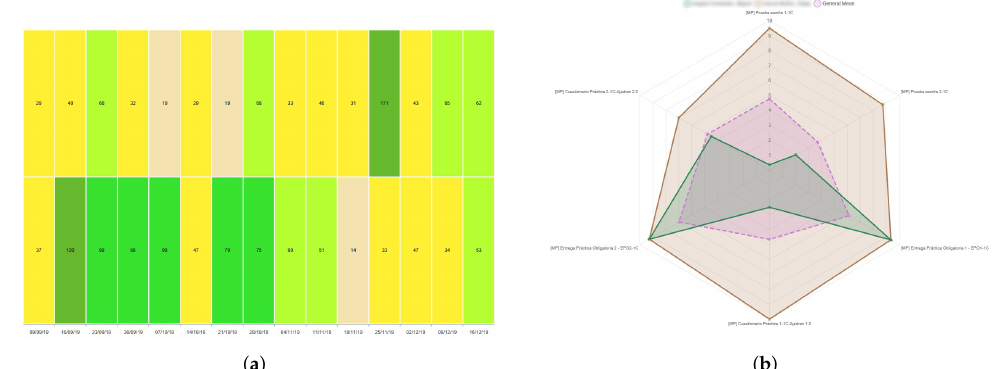
Figure 7. Comparison between a pair of students in a small group using different charts. ( a ) Heatmap. ( b ) Radar.